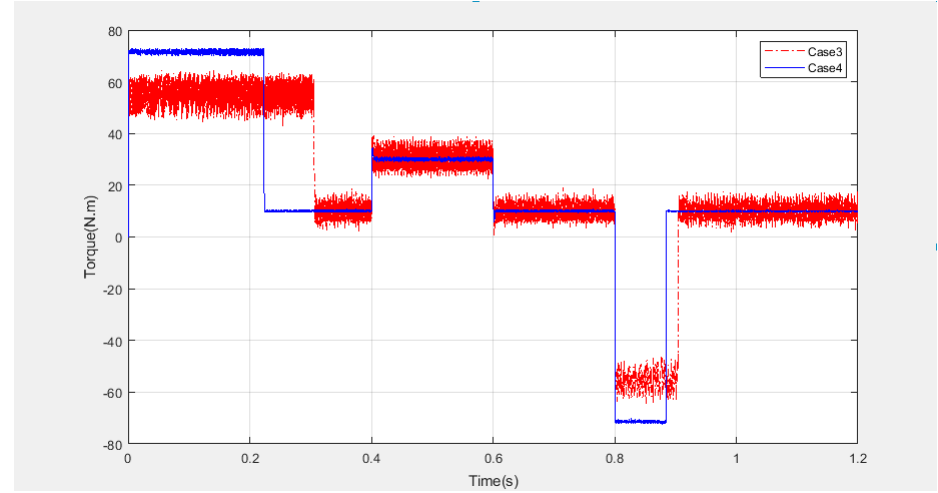
Figure 8. The torque response in Case 3 and Case 4.